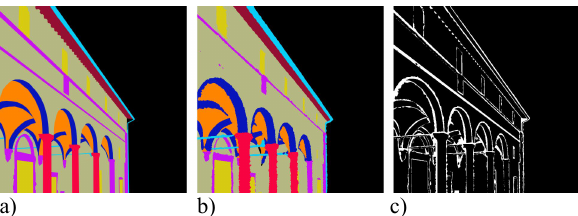
Figure 5 . a) Fine-manually segmented image, b) automatic segmented image, c) overlay between the two